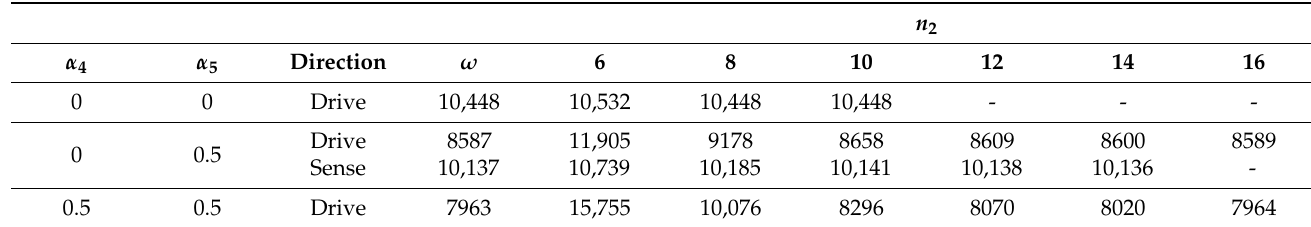
Table 1. The natural frequencies of the ROM of micro-gyroscope.